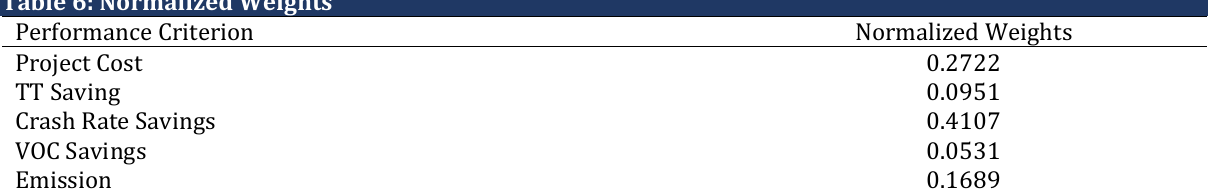
Table 6: Normalized Weights Performance